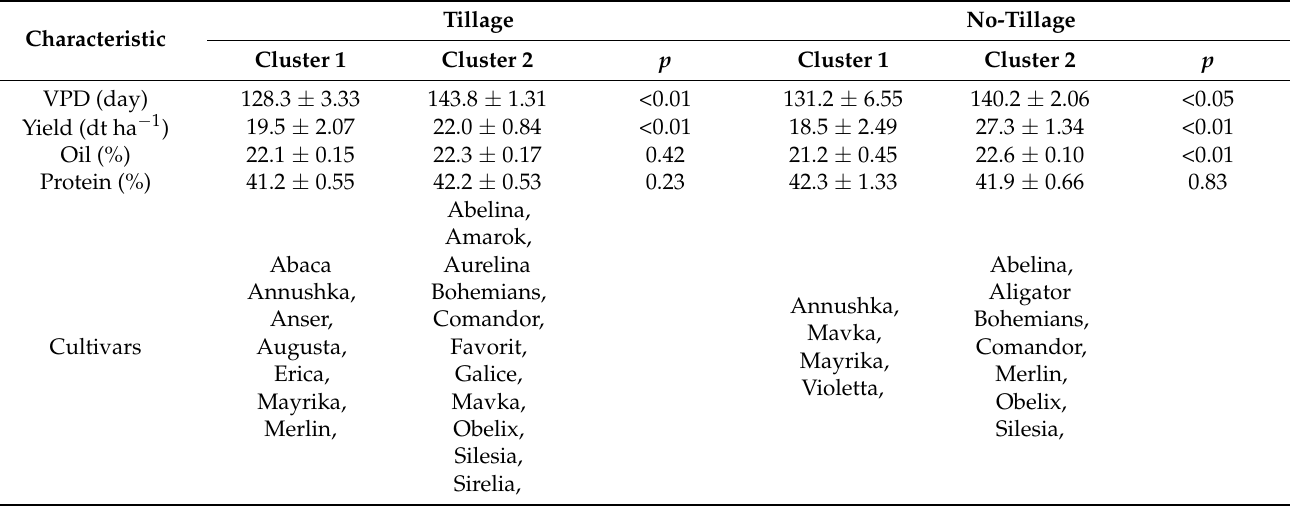
Table 8. Clusters of soybean cultivars in terms of vegetation period days, seed yield, oil content and protein content for tillage and no-tillage cultivation system. Means ± standard errors from the loca- tions and research years 2018–2020 in Central Poland.